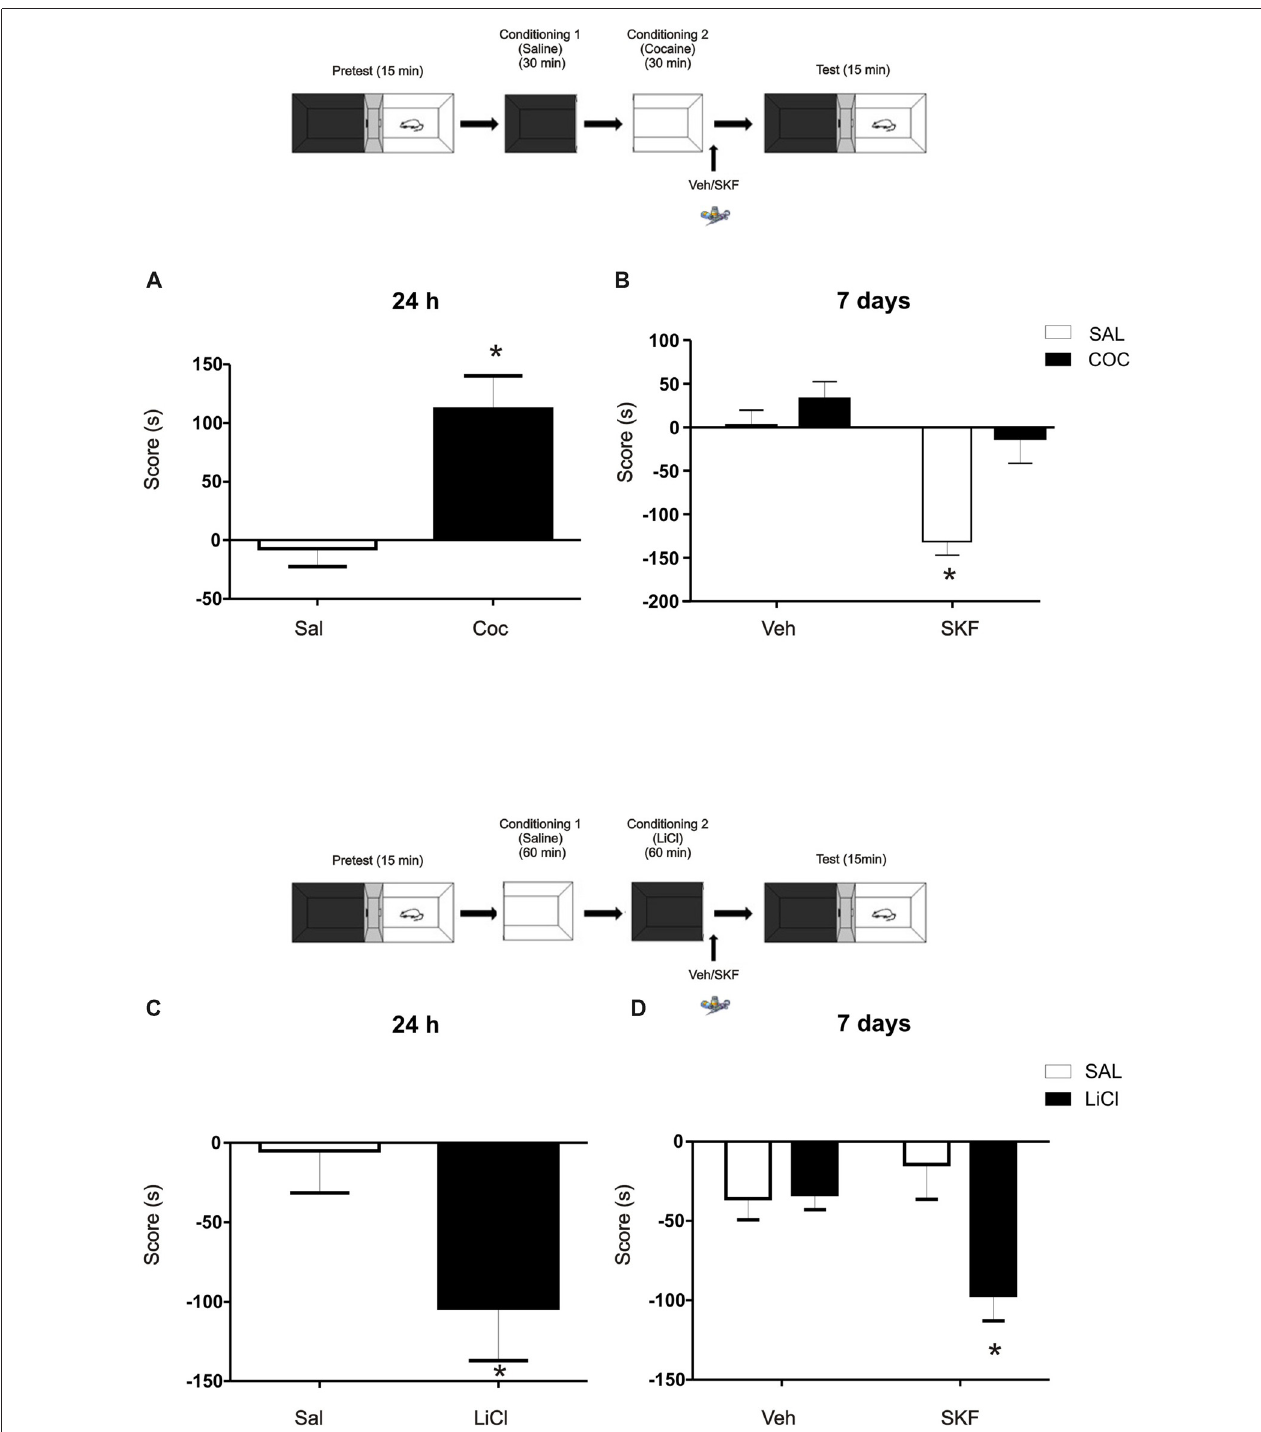
FIGURE 3 | Challenging effects of Cocaine or Lithium Chloride (LiCl) reverse or promote the effects of D1/5R activation on mPFC. (A) A single dose of cocaine (Coc, 20 mg/kg, i.p) generates a positive conditioning to the associate, white compartment when animals are tested at 24 h (Sal vs. Coc p = 0.003, n = 18–19). (B) The infusion of the D1/5R agonist SKF 38393 in the mPFC after a single cocaine conditioning does not generate the aversive behavior observed at 7 days (Tukey post hoc , p ( interaction ) = 0.0478, n = 10). (C) A single dose of LiCl (150 mg/kg i.p.) induces an aversive conditioning shown at 24 h but not at 7 days (Sal vs. LiCl p = 0.0032 n = 9). (D) Animals infused with the D1/5R agonist SKF 38393 or vehicle in the mPFC region immediately after the conditioning in the black compartment paired with LiCl promotes an aversive behavior 7 days later (Tukey post hoc p ( interaction ) = 0.0137 n = 10–11). ∗ p < 0.05.